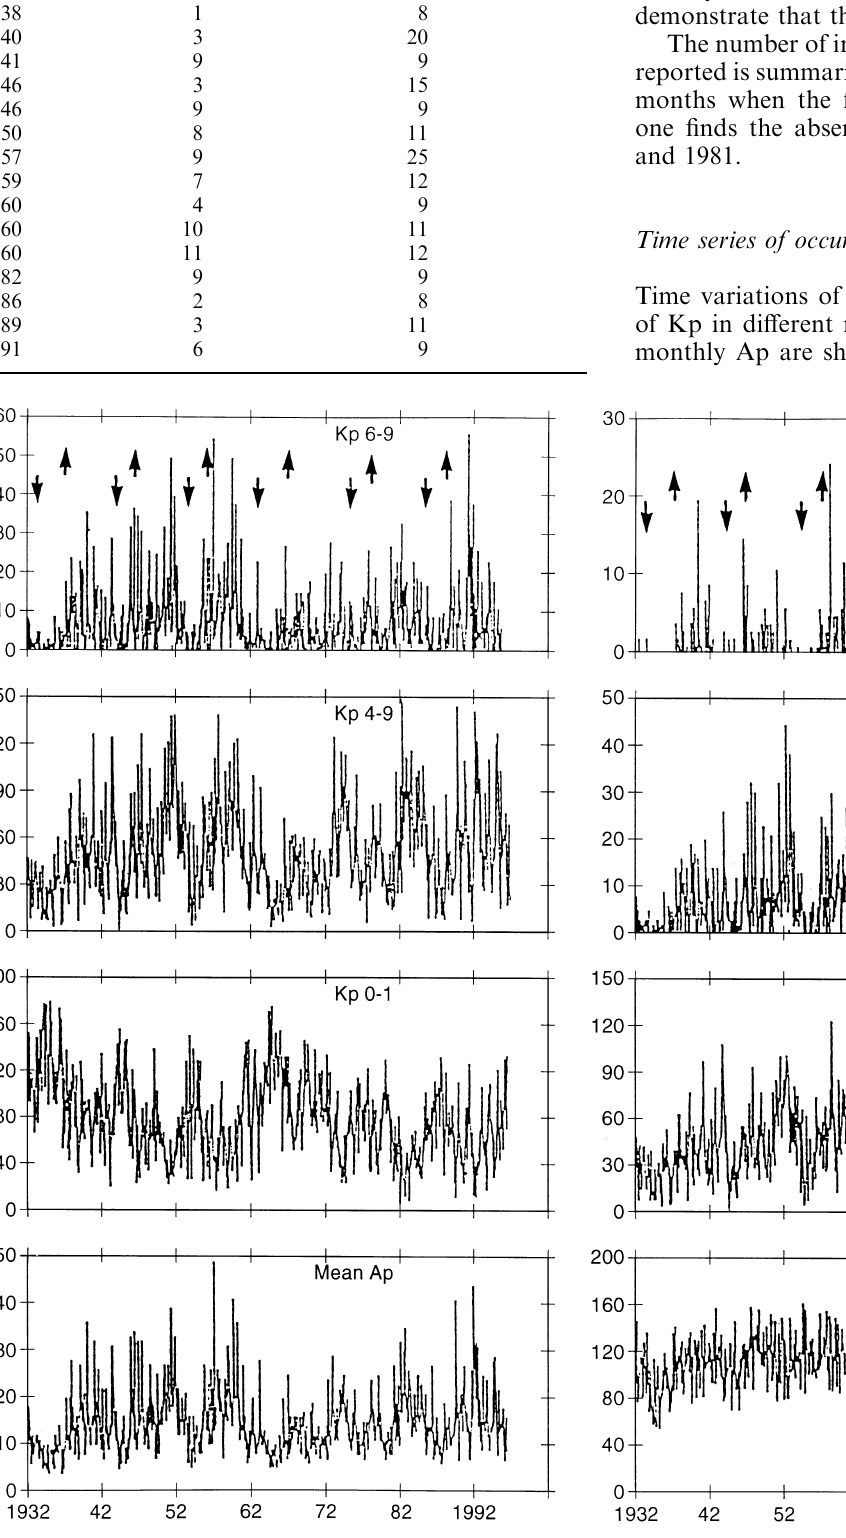
Fig. 1. Monthly mean values of Ap index and occurrence frequencies of Kp index in di(cid:128)erent categories from 1932 to 1995. Upward arrows indicate solar maximum epoch and downward arrows indicate solar minimum